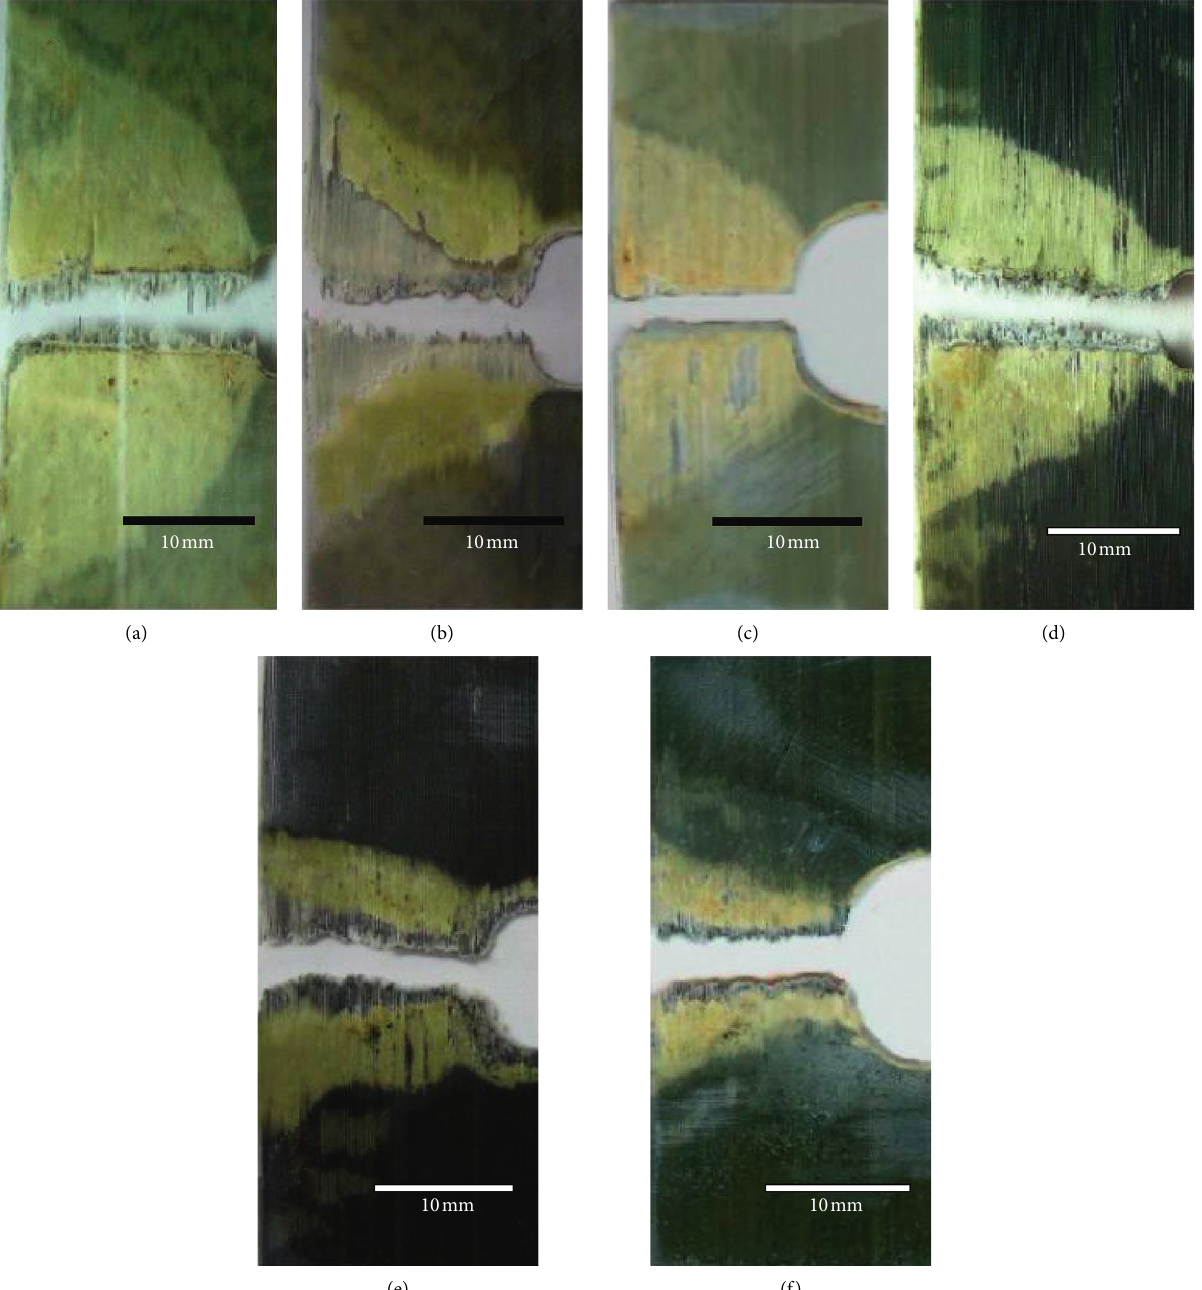
Figure 19: Images of delamination profiles after chemical removal of aluminum layers of type I hybrid FMLs with notch size of (a) D � 1/8in., (b) D � 1/4in., and (c) D � 1/2in. and type II hybrid FMLs with notch size of (d) D � 1/8in., (e) D � 1/4in., and (f) D � 1/2in.